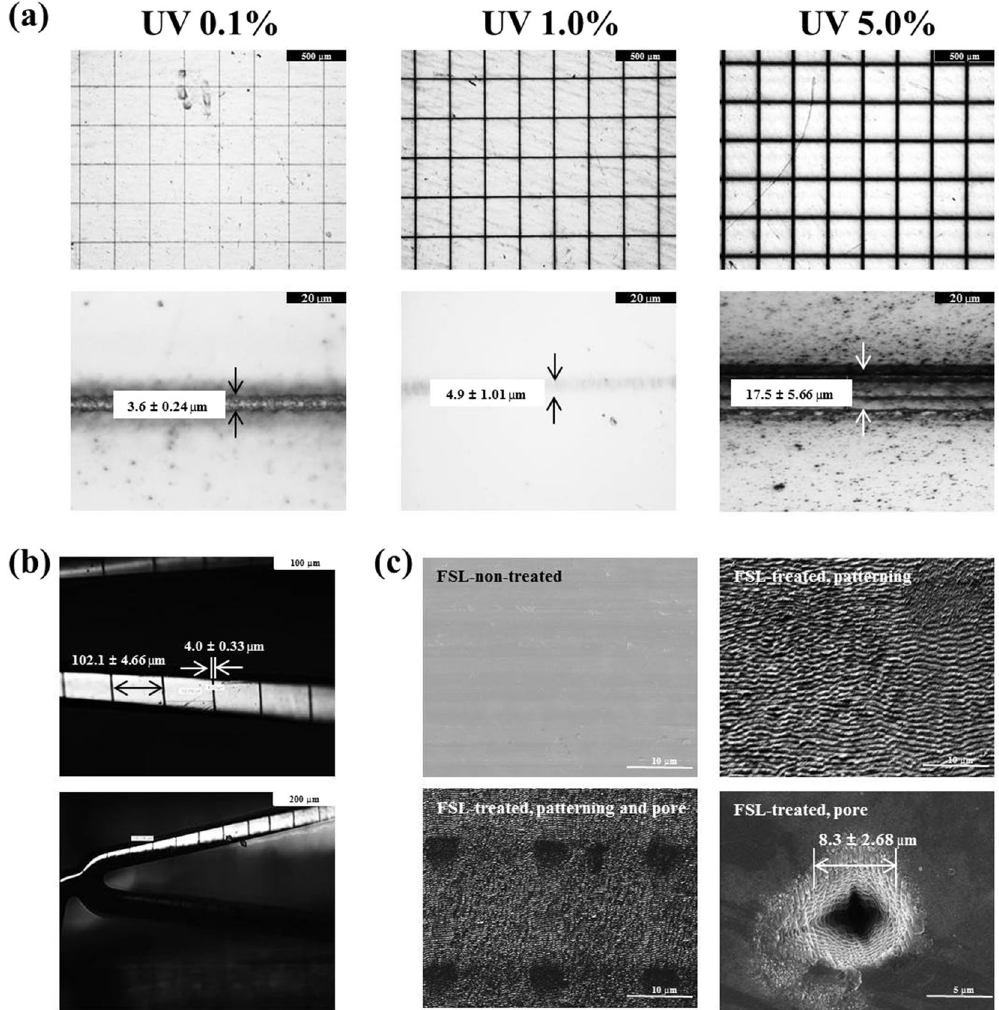
Figure 1. Morphological analysis after femtosecond laser irradiation. Representative SEM images of surfaces 2-D plates ( a ) and 3-D tubular stents ( b ) under various irradiation conditions. Representative images of patterning and pores on stent surfaces after femtosecond laser irradiation ( c